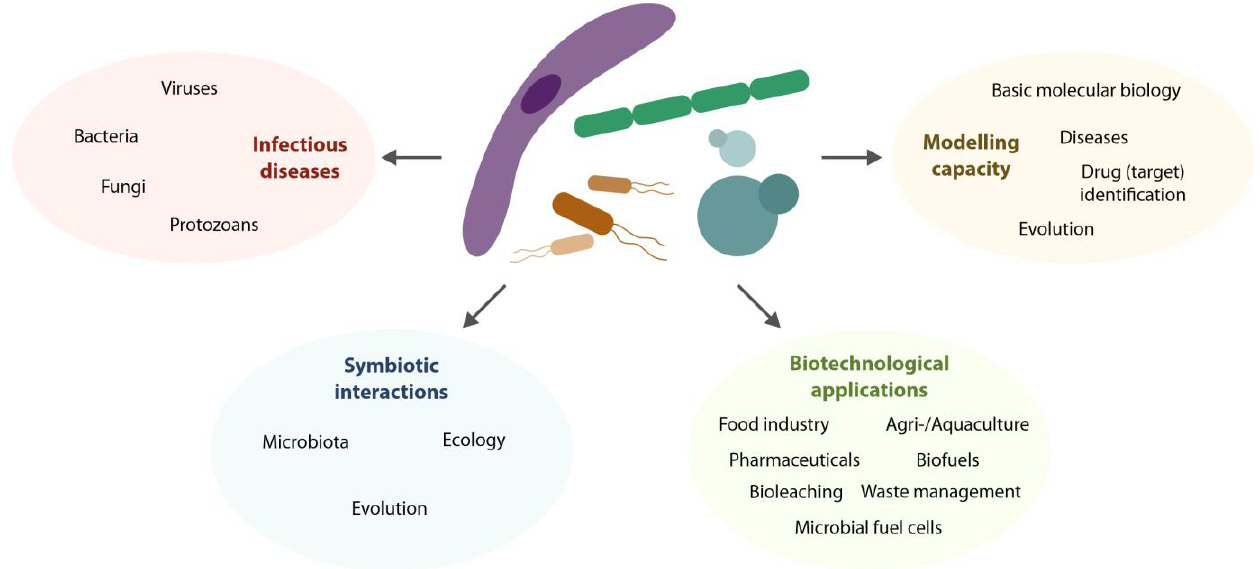
FIGURE 1: The multilayered impact of microorganisms on our